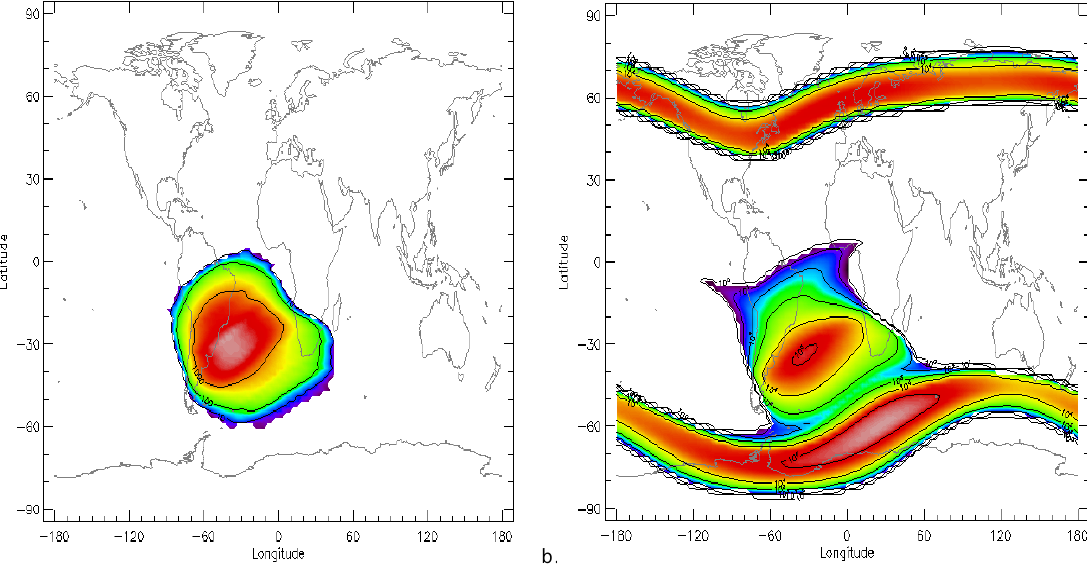
Figure 7. Intended main targets for RADMON; a) 10 or more MeV proton fluxes at a 700 km orbit height. b) 700keV or more fluxes at the same height, produced by ESA Space Environment Information System (SPENVIS).